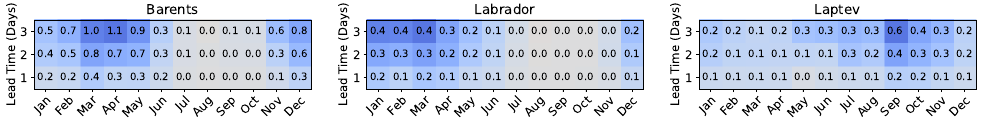
Figure 15. Improvement of JAXA SIC MAE (in percentage points, higher is better) for general U-Net (R) with GFS over general U-Net (R) without GFS for different months of 2021 and different forecast horizons (in days). The matrix for each region and subfigure is color-coded independently in a red-blue scheme to provide a better perception of the relative improvement for each month and forecast day in the corresponding region. The numbers in each cell are rounded and should be used to estimate the overall improvement scale in the regions. Improvement is computed in absolute percentage points and tends to be higher for months with active sea ice